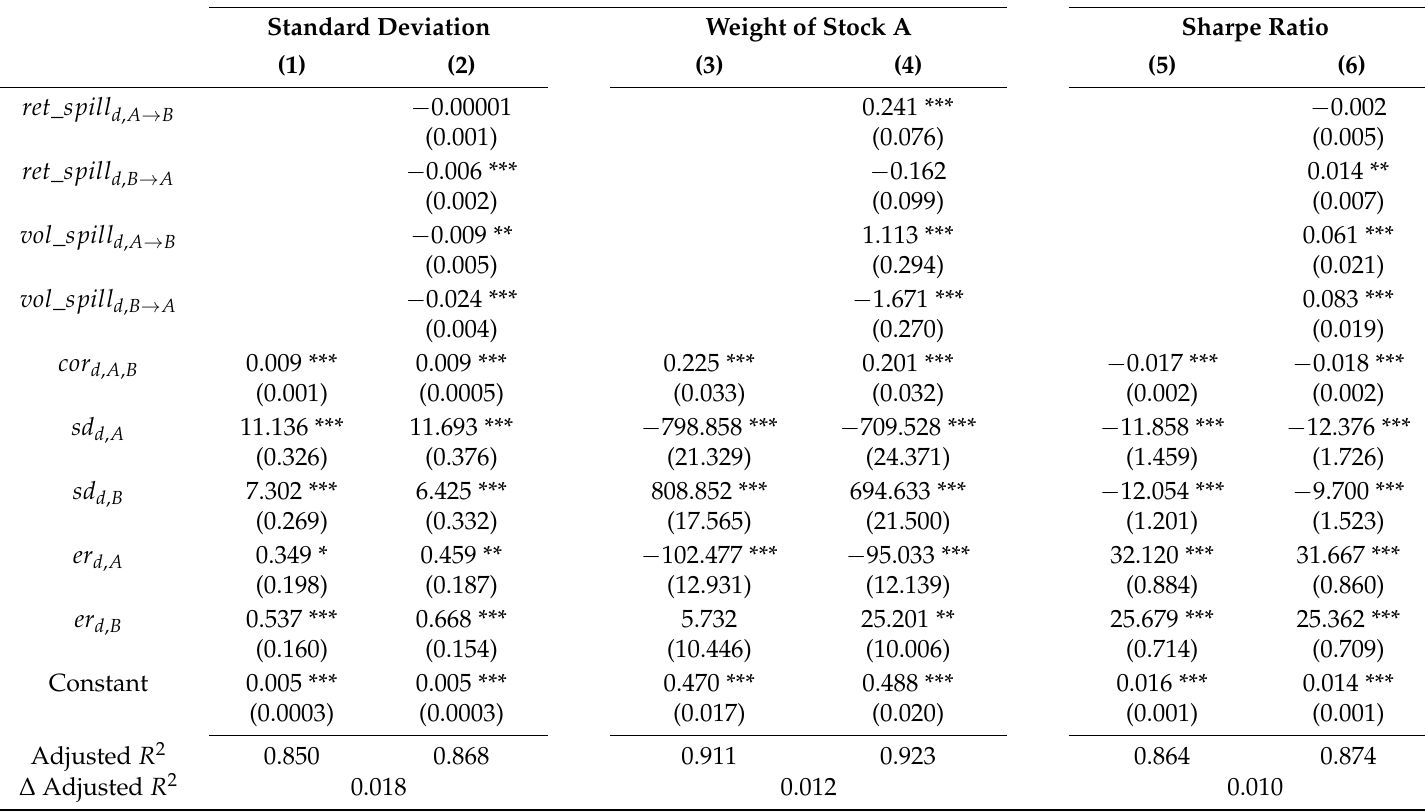
Table 6. Empirical analysis—Effects of spillovers on optimal portfolios. This table presents regression results of model (9) and its nested model without spillovers as independent variables. For each two-asset ( A and B ) portfolio formed from 30 DJIA constituents, we estimate return spillover ( ret _ spill A → B and ret _ spill B → A ), and volatility spillover ( vol _ spill A → B and vol _ spill B → A ) from one to the other. Then, we calculate minimum variance and maximum Sharpe ratio of the portfolio, along with their corresponding weights of asset A as dependent variables. Control variables include correlation ( cor A , B ), standard deviations ( sd A and sd B ) and expected returns ( er A and er B ) either at daily frequency (Panel A) or weekly frequency (Panel B). The last row of each Panel presents the difference in adjusted R 2 of the full model and the restricted model without spillovers. t-statistics are in parentheses. *, **, *** denote significance level at 10%, 5%, and 1%,